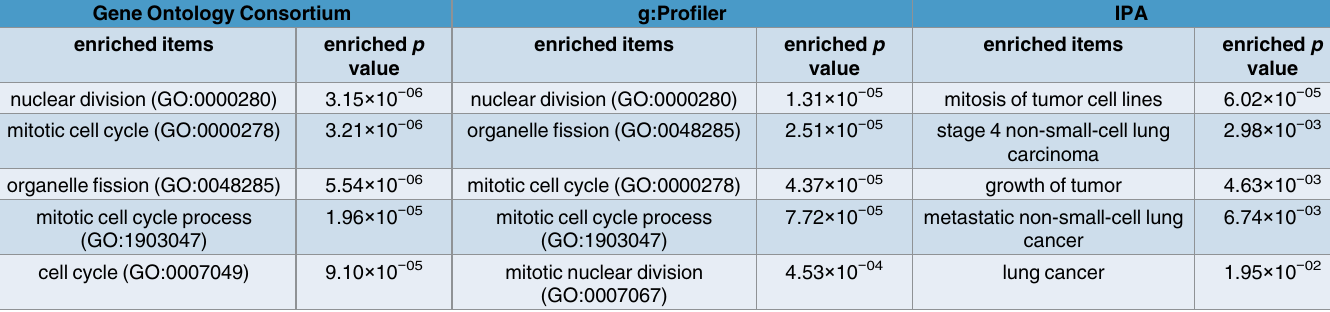
Table 3. The functional enrichment of sDNB genes in at least 80% of samples for